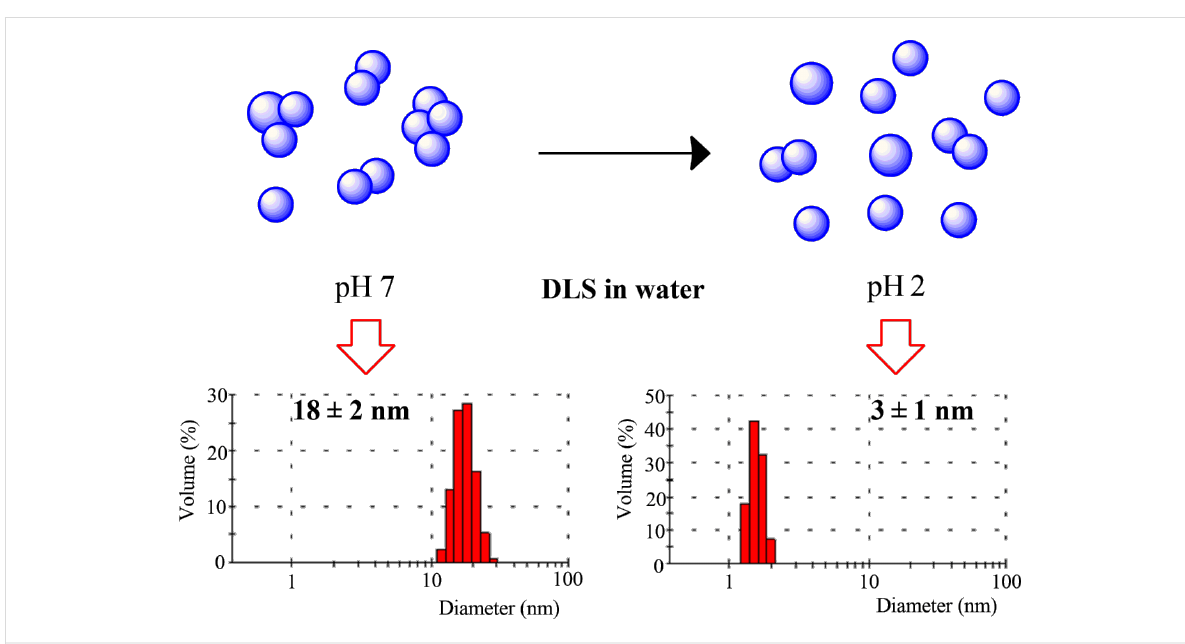
Figure 6: FESEM images of Pt-DEA nanoparticles (Pt/DEA 1:0.25).